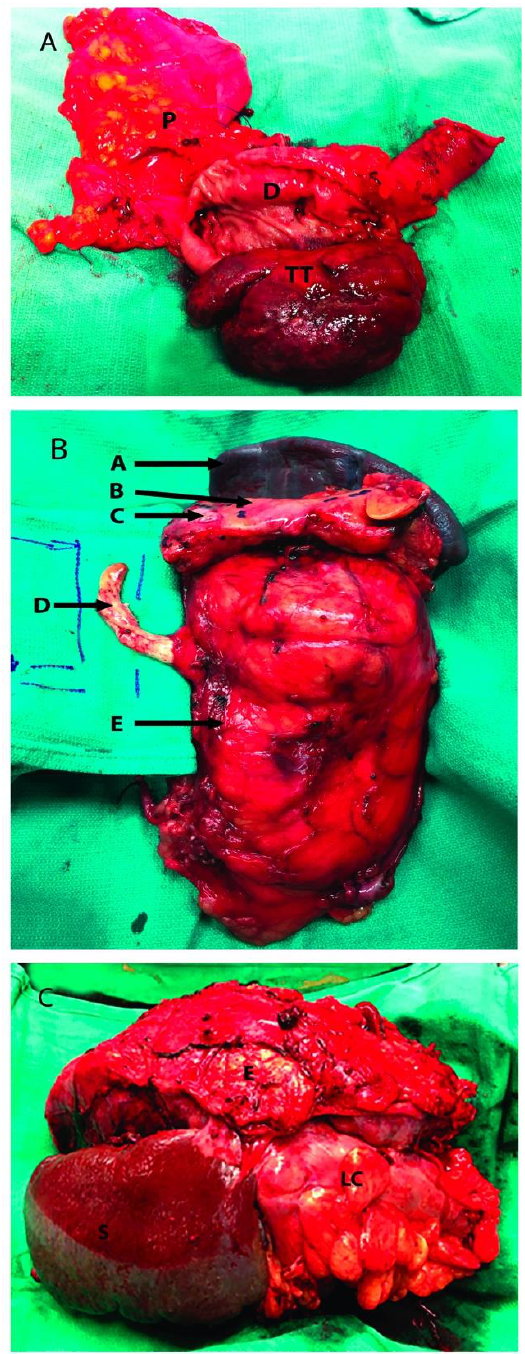
Figure 2. Renal tumor involving adjacent organs. ( A ): Head of the pancreas resected along with a portion of duodenum; ( B ): Left radical nephrectomy specimen with resection of IVC tumor thrombus, pancreas and spleen; ( C ): Left kidney tumor resected with adjacent organs, the distal pancreas was not visualized. P: Head of pancreas; D: 2nd portion of duodenum; TT: Tumor thrombus inside the second portion of the duodenum; A: Spleen; B: Pancreas; C: Pancreatic metastatic mass; D: Tumor Thrombus going inside the inferior vena cava; E: Kidney Tumor; S: Spleen; LC: Left Colon.